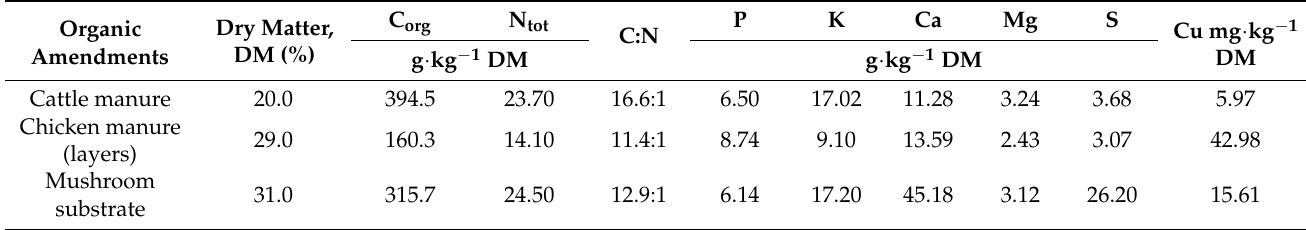
Table 1. Some properties of organic amendments used in